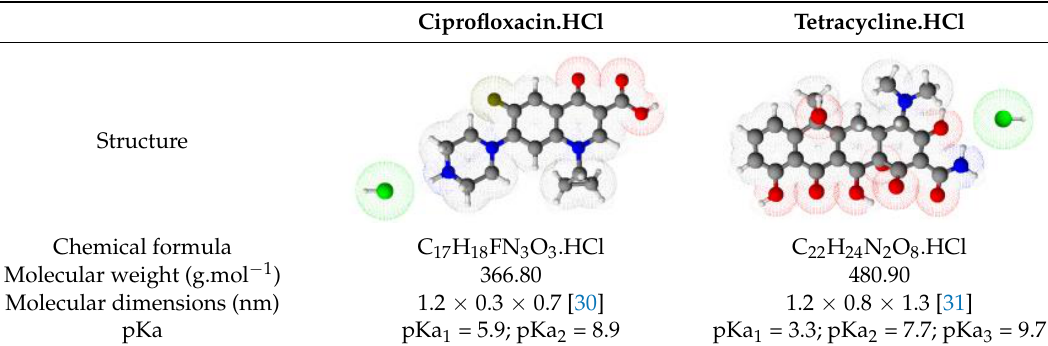
Table 1. General characteristics of the antibiotics used.